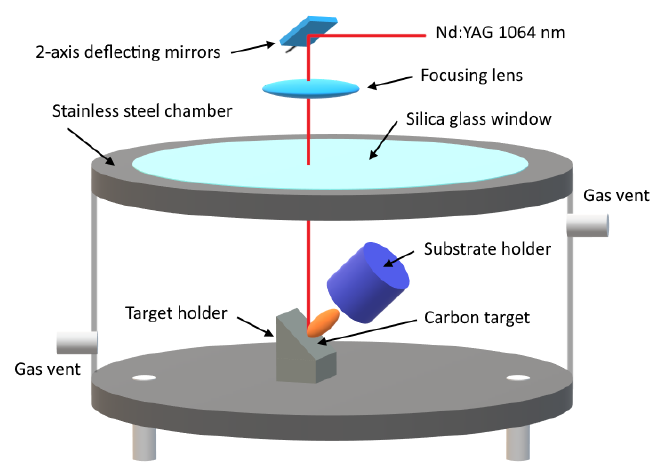
Figure 1. Schematic of the laser ablation process.